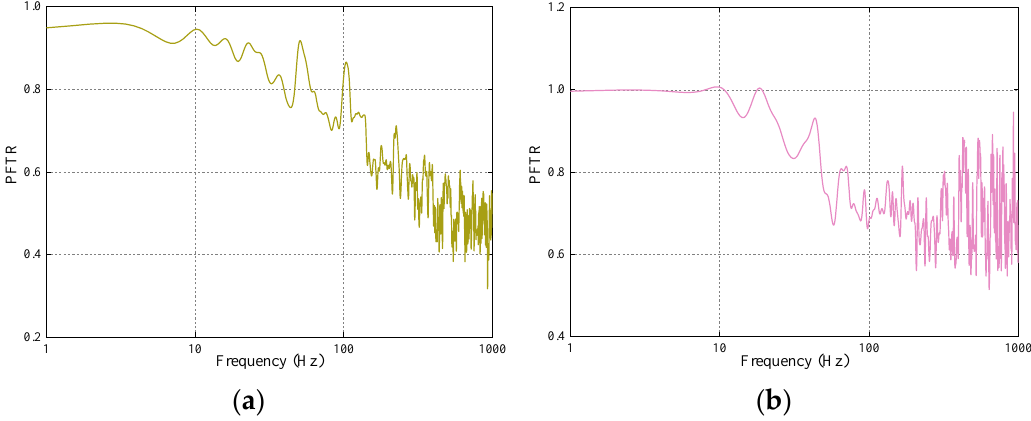
Figure 5. The power flow transfer rates (PFTRs) from ( a ) the rail to the slab track and ( b ) the slab track to the bridge.